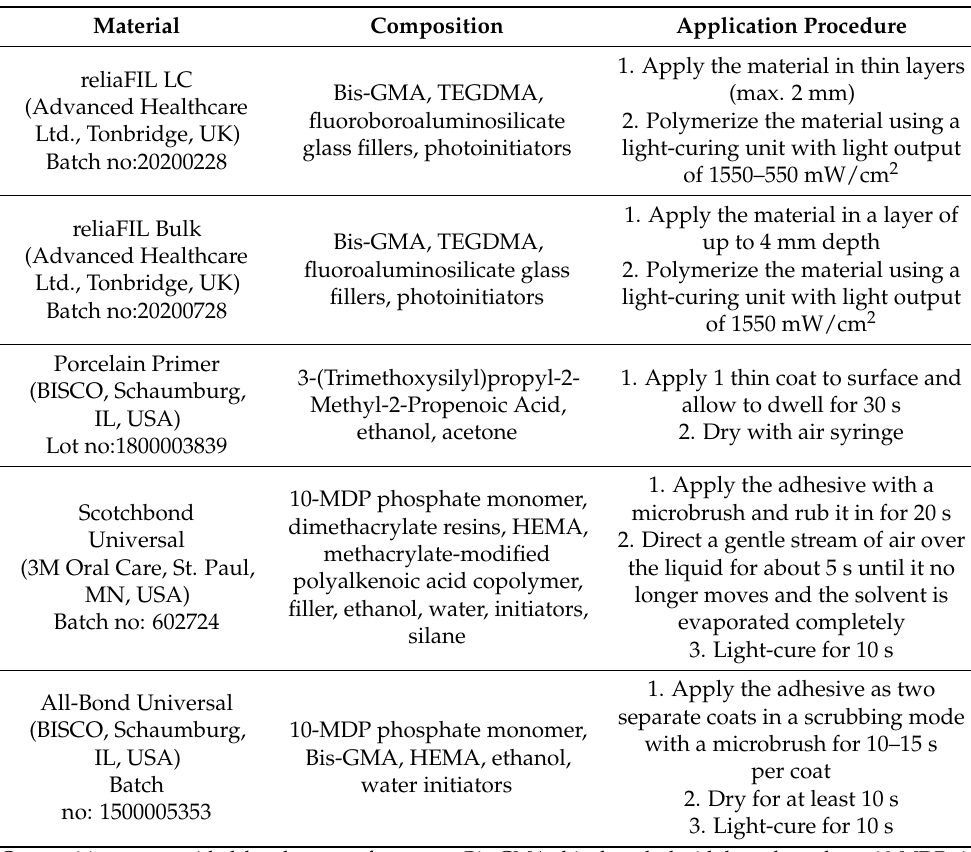
Table 1. The materials, chemical composition, and application procedure. Material